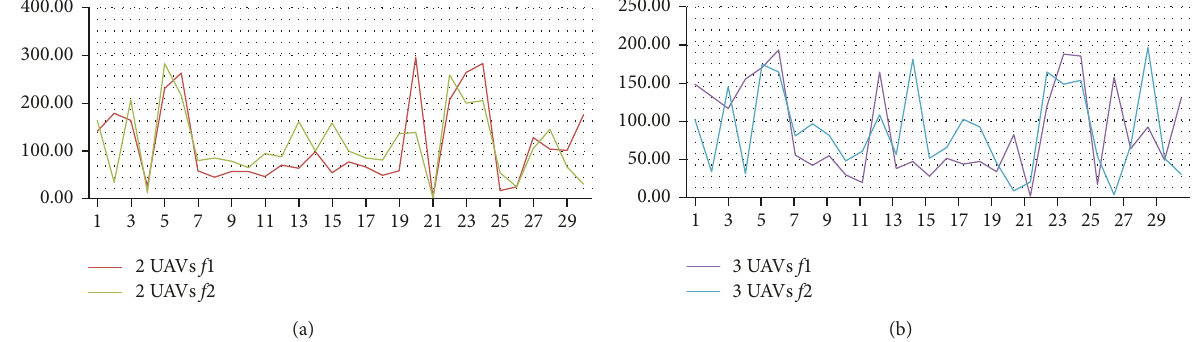
Figure 17: La Palma attraction path planning results for 2 UAVs (a) and 3 UAVs (b).